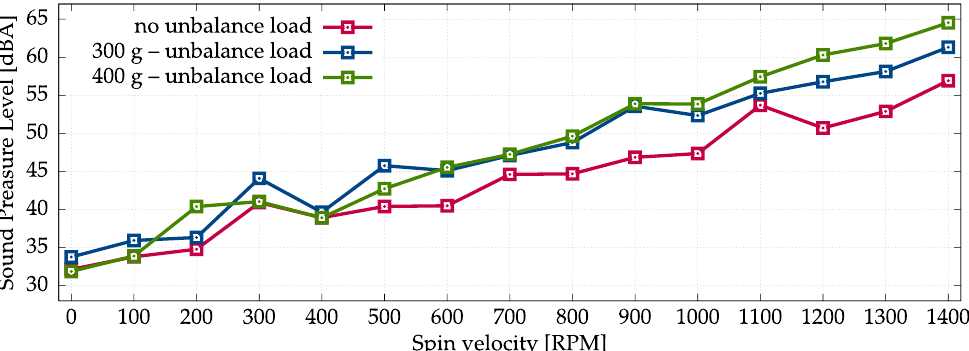
Figure 3. Average Sound-Pressure Level measured at M0–M3 locations using four measurement mi- crophones.